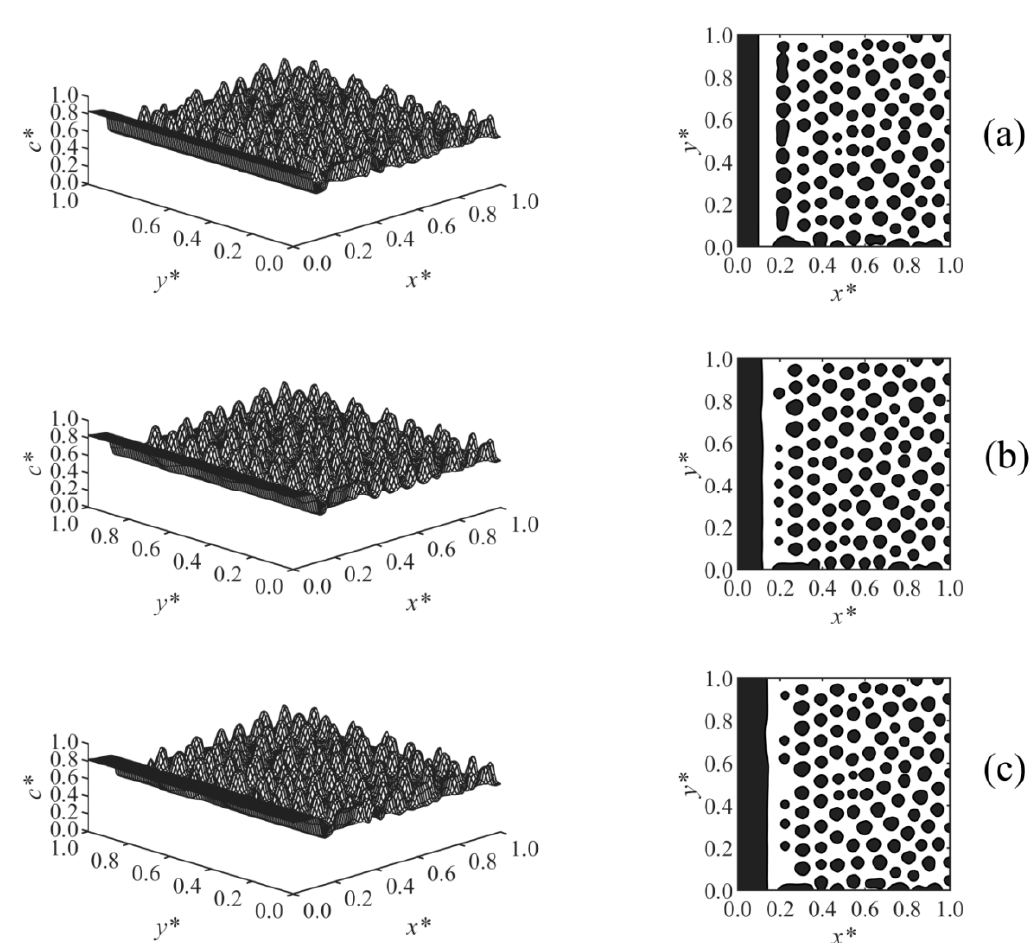
Figure 4. Spatial concentration distributions (first column) and phase-separated morphologies (second column) for Case 2 at t * = 9.85 × 10 − 5 , at the following surface potential parameters: ( a ) h 1 = 0.25, ( b ) h 1 = 0.5, and ( c ) h 1 = 2.